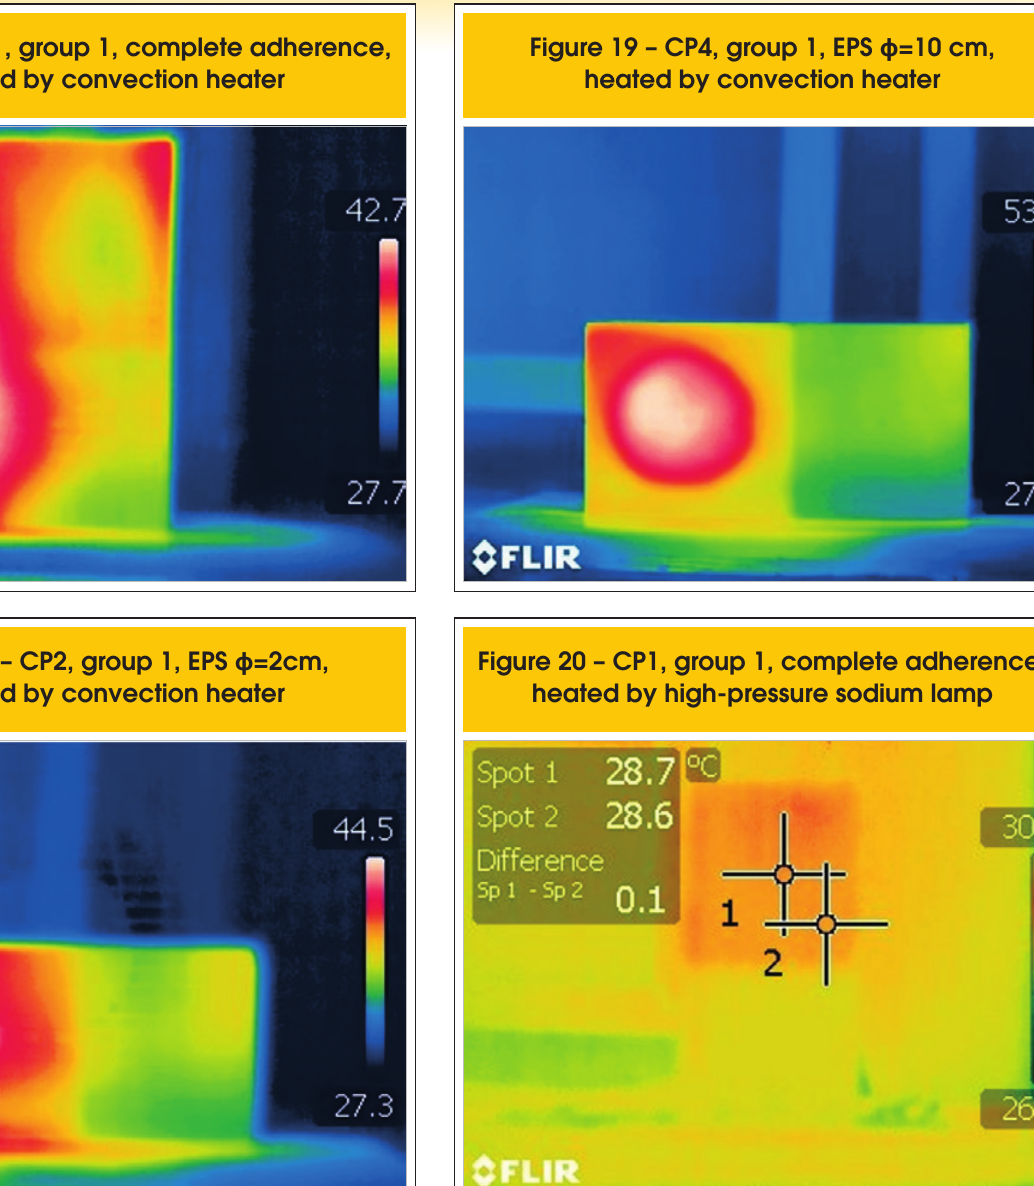
Figure 18 – CP3, group 1, EPS ϕ =6 cm, heated by convection heater